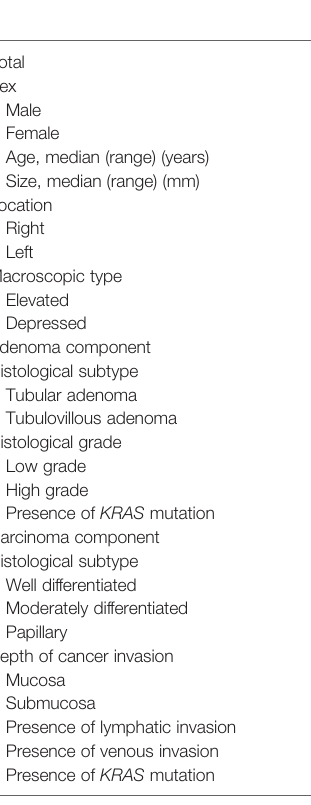
TABLE 1-B | Clinicopathological fi ndings of the colonic adenocarcinomas in/with